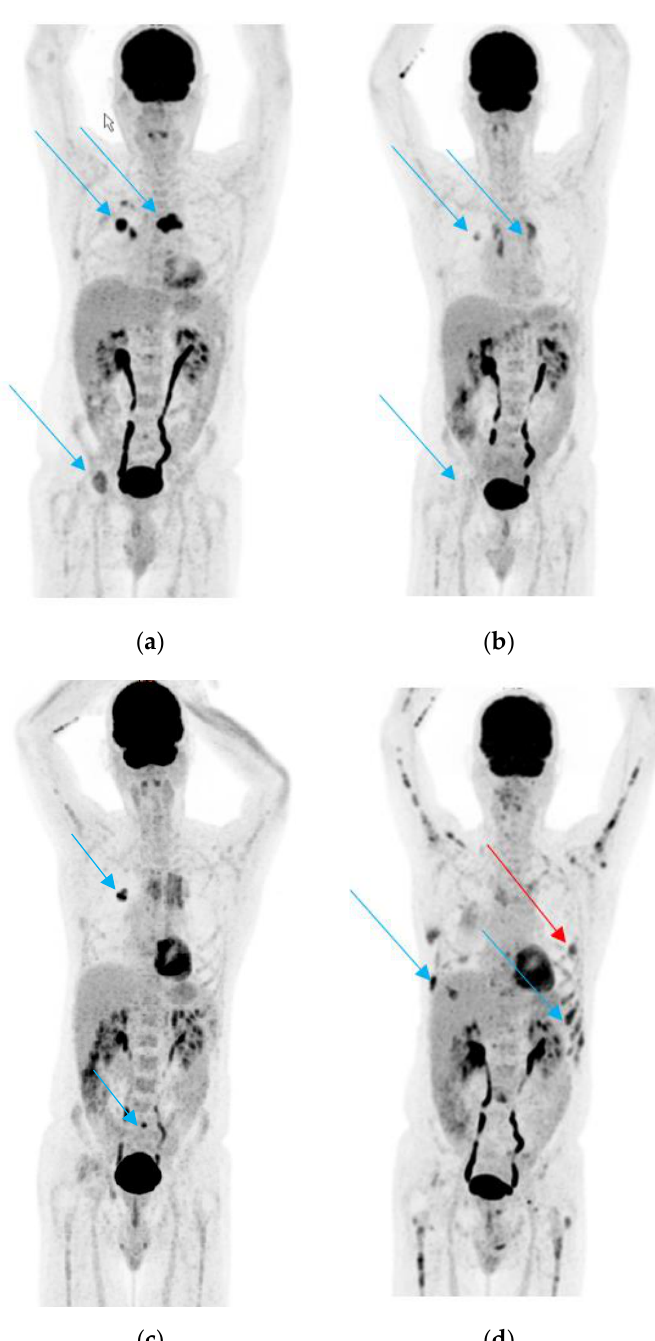
Figure 1. ( a ). 18 F-fluorodeoxyglucose positron emission/computed tomography ( 18 FDG-PET/CT) scan performed before start of treatment; the arrows show the primary tumor in the lung and some of the bone metastases. ( b ). 18 FDG-PET/CT scan performed after 3 months of treatment with erlotinib and bevacizumab. The arrows show partial remission of the primary tumor and the bone metastases. ( c ). 18 FDG-PET/CT scan performed after 9 months of treatment with erlotinib and bevacizumab. The blue arrows show the slight progression of the primary tumor and in the sacrum. ( d ). 18 FDG-PET/CT in January 2019. The blue arrows show new diffuse bone metastasis of several skeletal regions and the red arrow a new pleural lesion, which was biopsied.